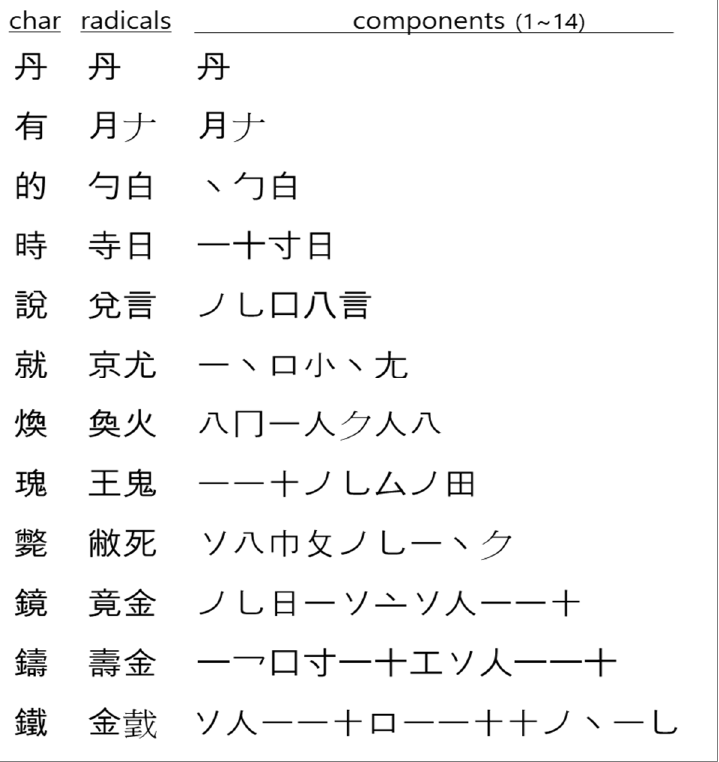
Figure 7. Examples of components from a character.